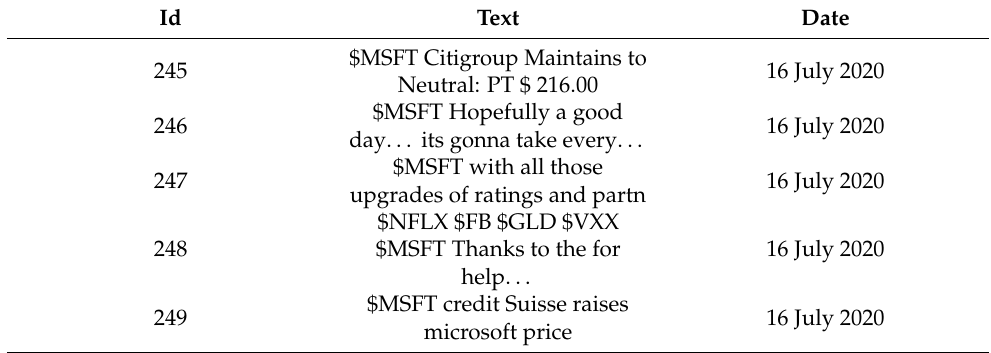
Table 2. Sample of StockTwits data.